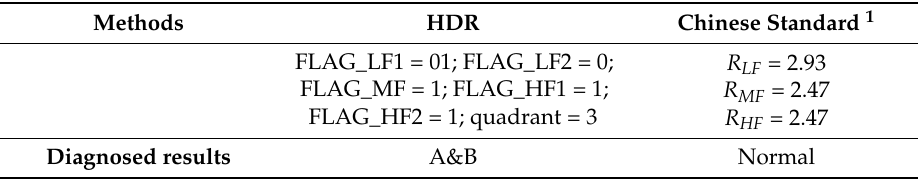
Table 3. Diagnosis result of Case